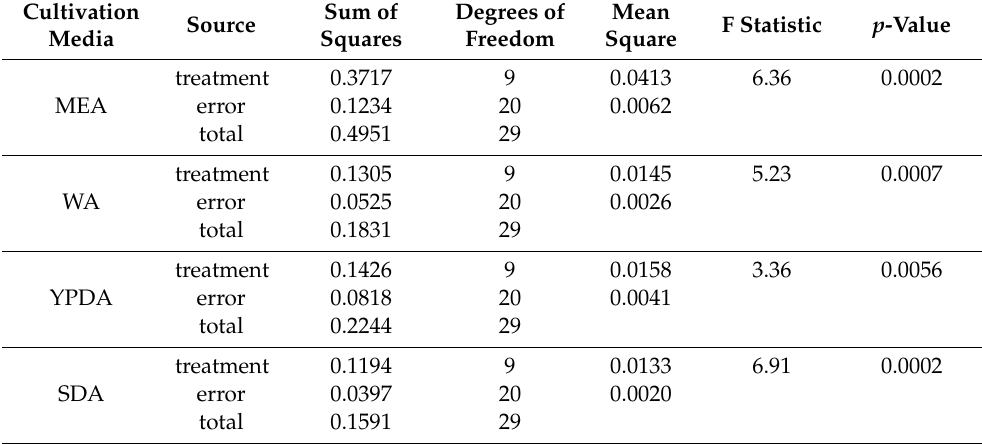
Table 5. One-way ANOVA results for the analyzed wine varieties—federweisser.